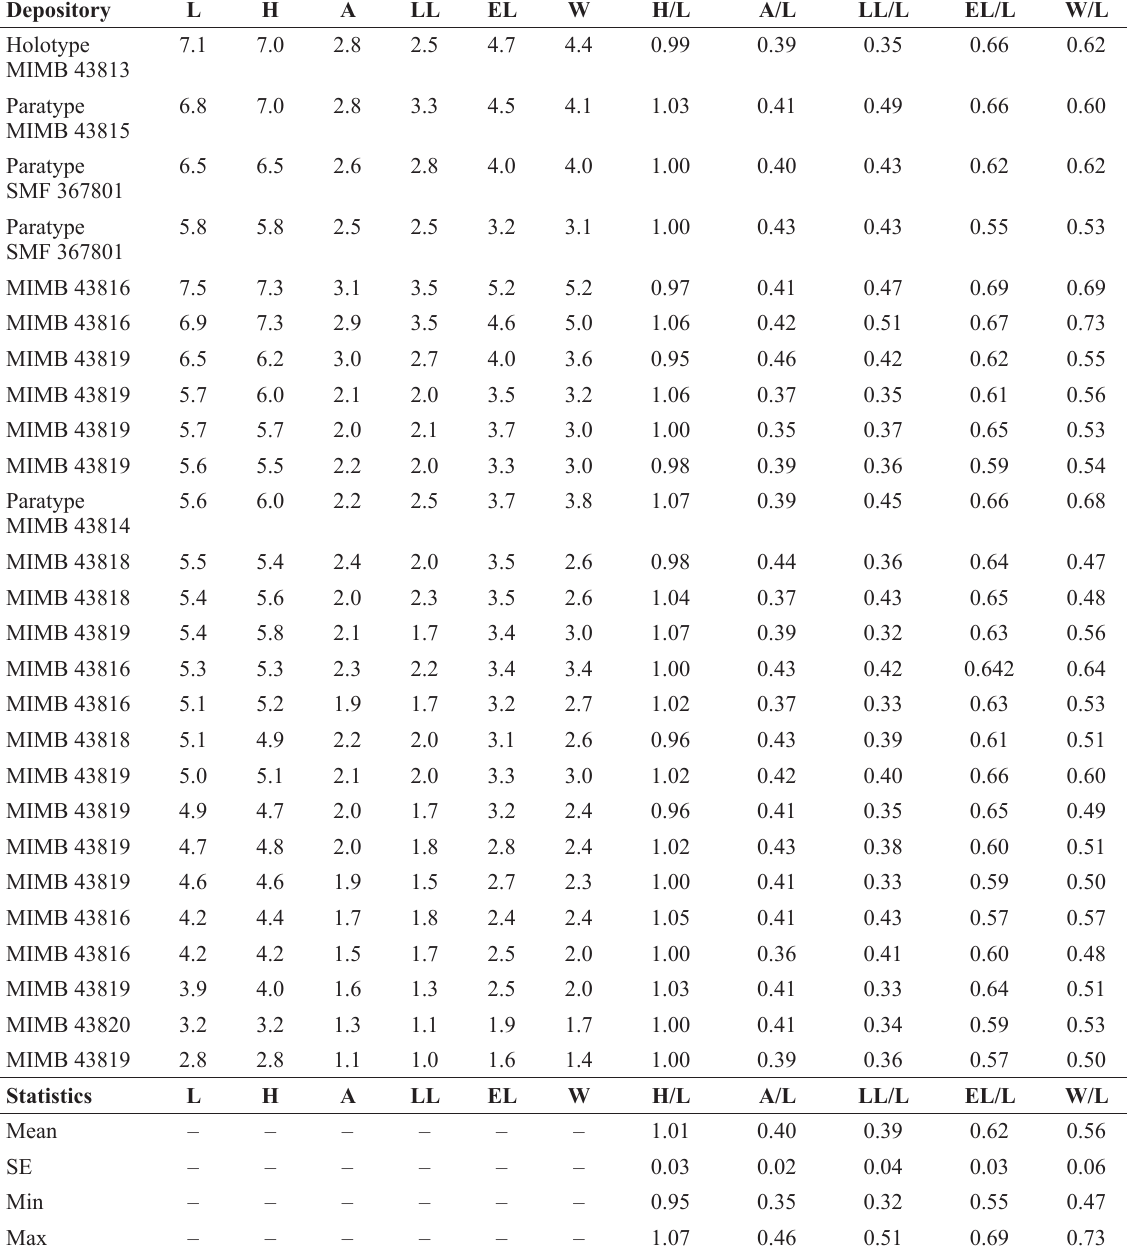
Table 1. Parathyasira coani sp. nov., shell measurements (mm), indices and summary statistics of